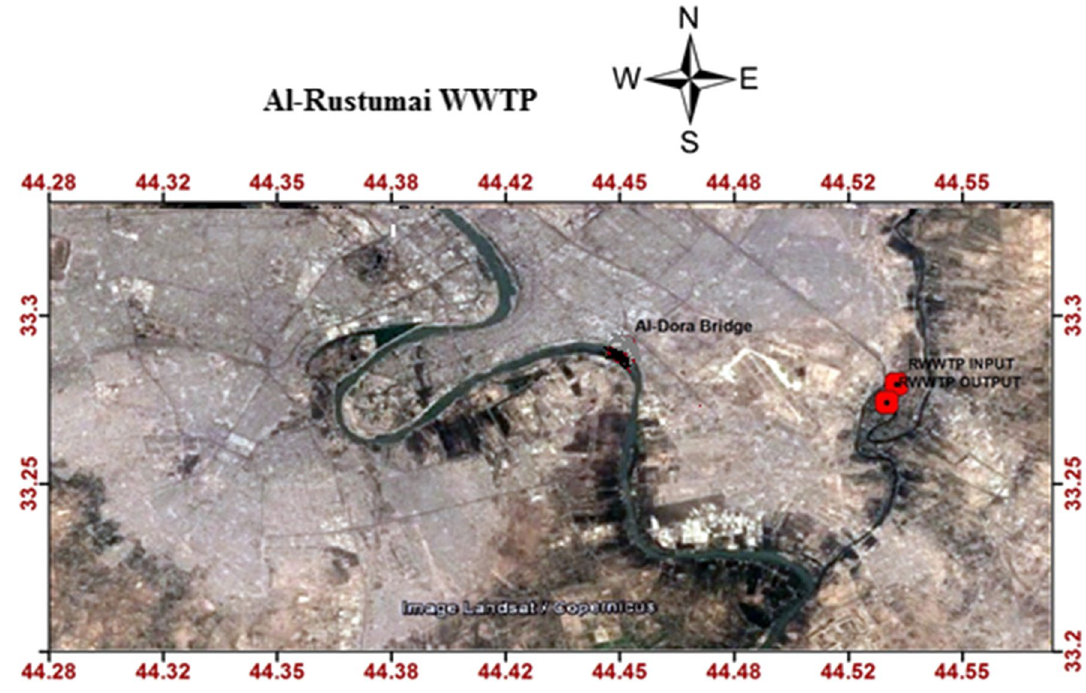
Fig. 1 Map showing location of Al-Rustumia (WWTP) on Diyala River